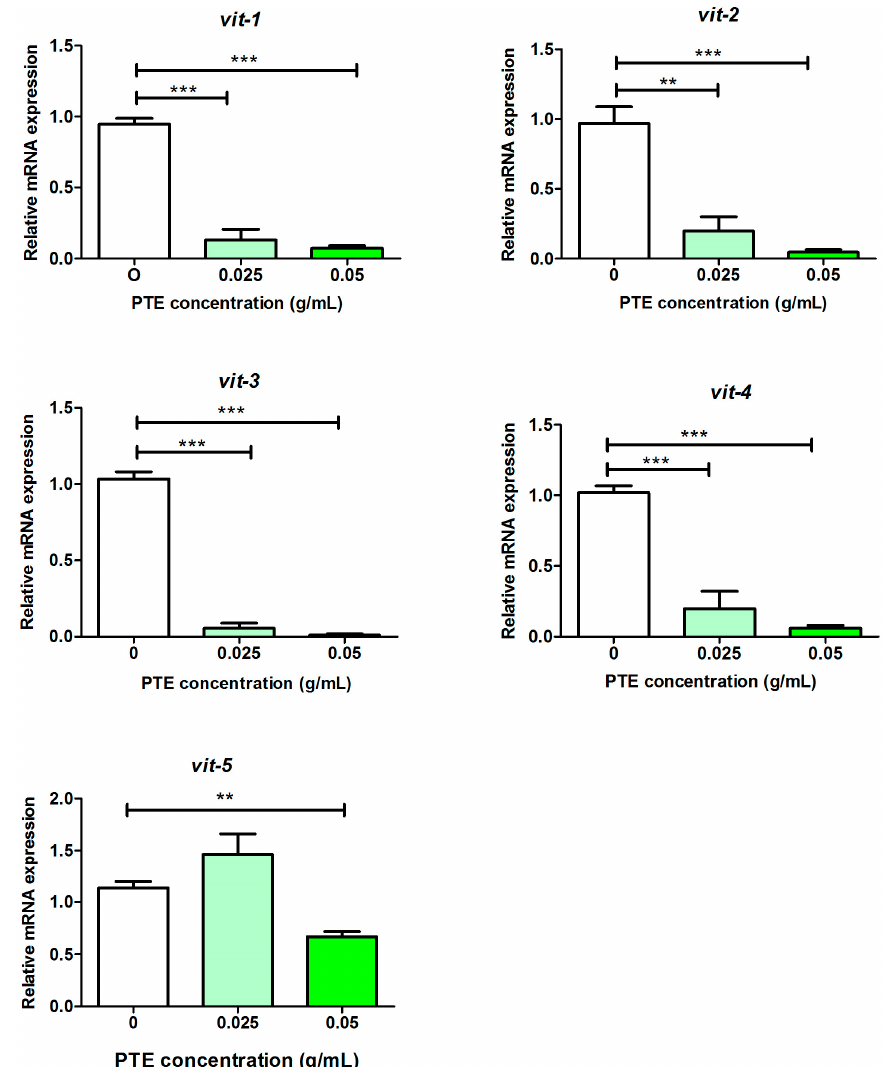
Figure 2. Relative mRNA expression of vit-1, vit-2, vit-3, vit-4, and vit-5 by qPCR. Data are presented as mean ± SEM of four biological repeats. Significant differences between the control group and a specific PTE treated group, *** p < 0.001, ** p < 0.01.